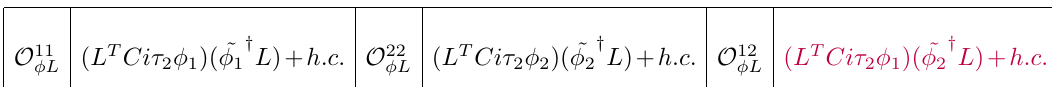
Table 3. 2HDM: (cid:30) 2 L 2 [3